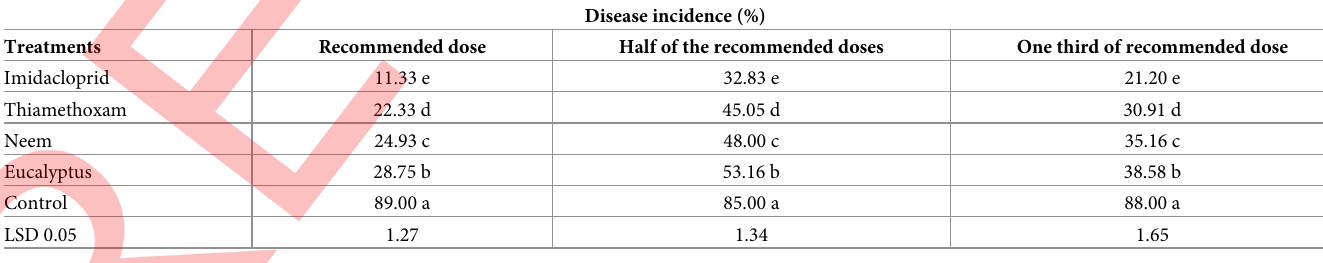
Table 5. The impact of doses of various insecticides and plant extracts on the incidence of MYMV under field conditions.